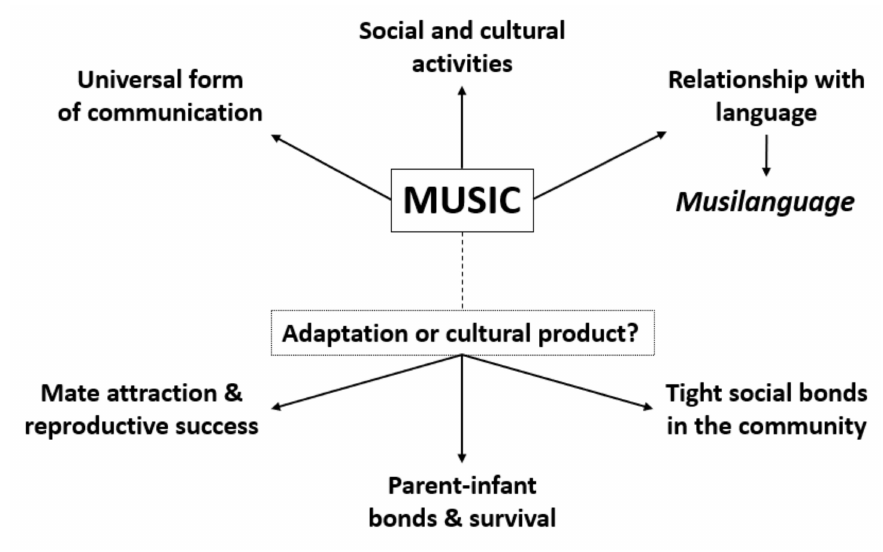
Figure 1. Schematic representation of the hypothesis of the evolution of